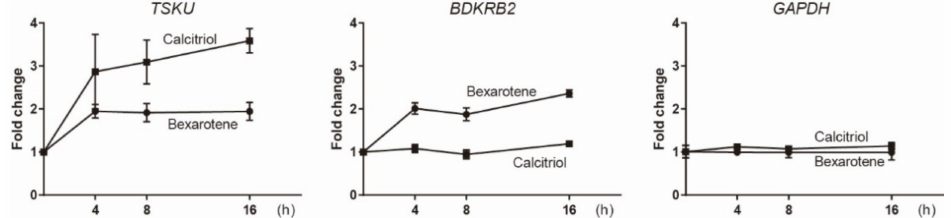
Figure 2. Real-time PCR analysis of the expressions of endogenous TSKU and BDKRB2 upon stimulation by 10 µ M bexarotene or 1 µ M calcitriol. HPRT1 was used as the internal control. The graphs show the mean of two experiments per gene with three measurements each. Error bars indicate